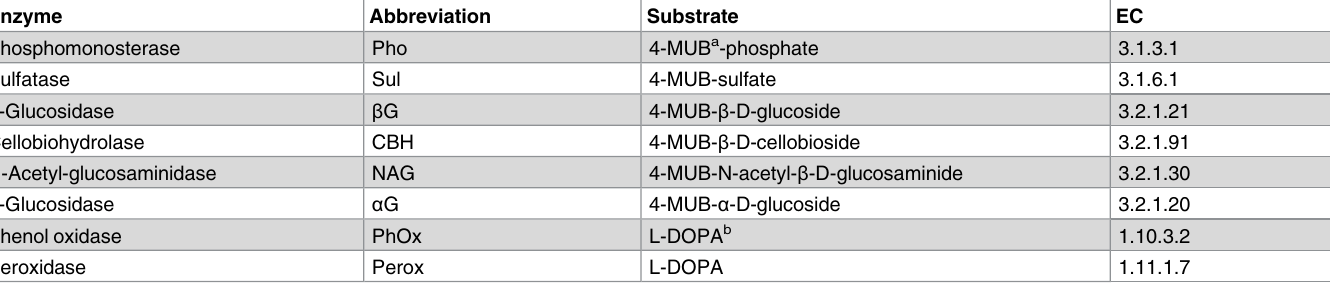
Table 1. Enzymes with corresponding commission number (EC), corresponding substrate, and the abbreviation used in this study.